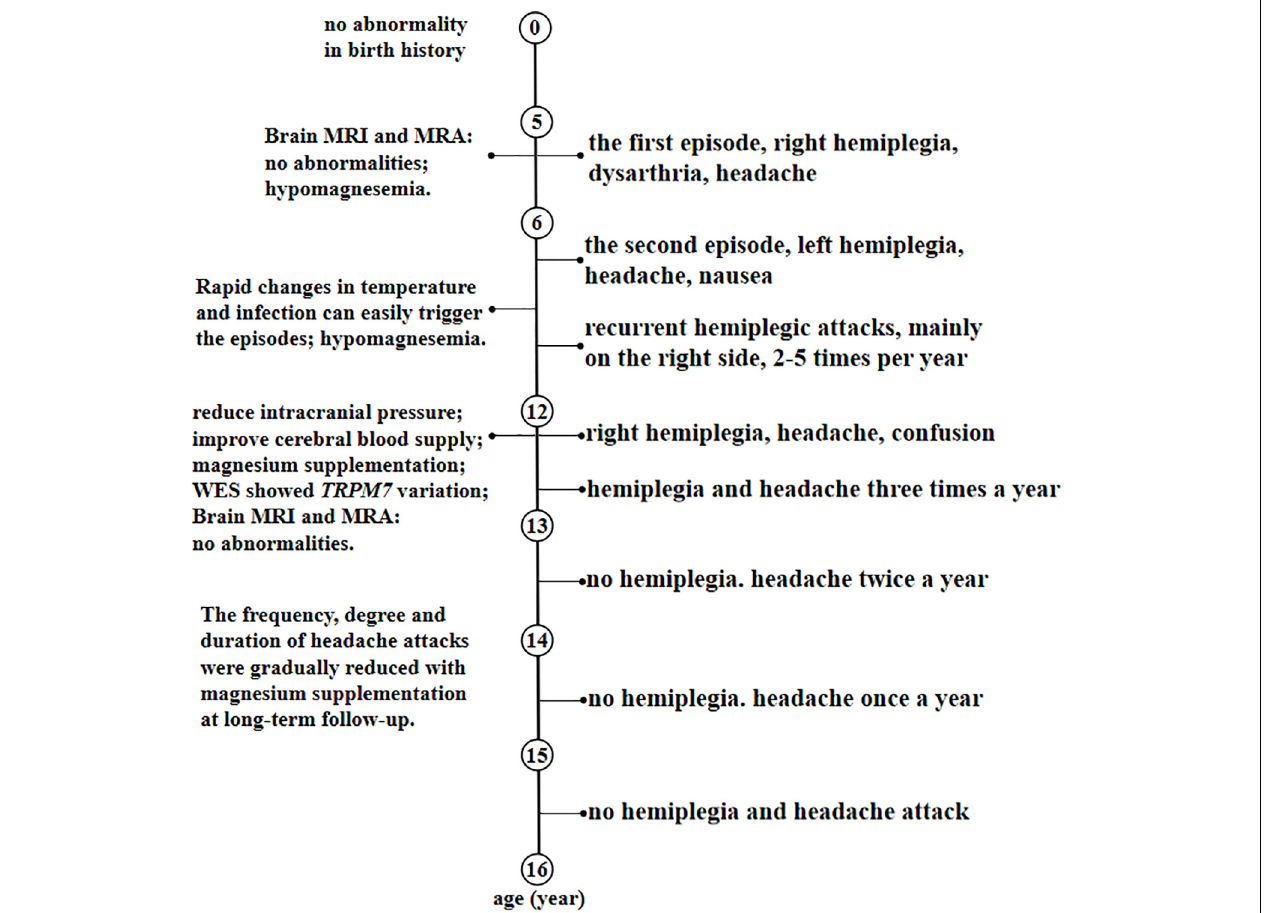
FIGURE 4 | A timeline with relevant data from the patient episode of